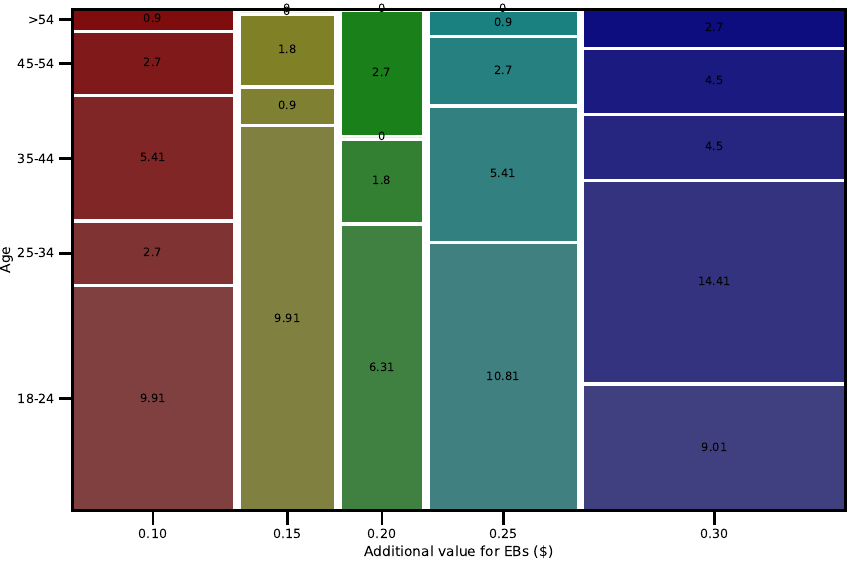
Figure 7. Mosaic plot of the willingness to pay an additional value for EBs based on gender.